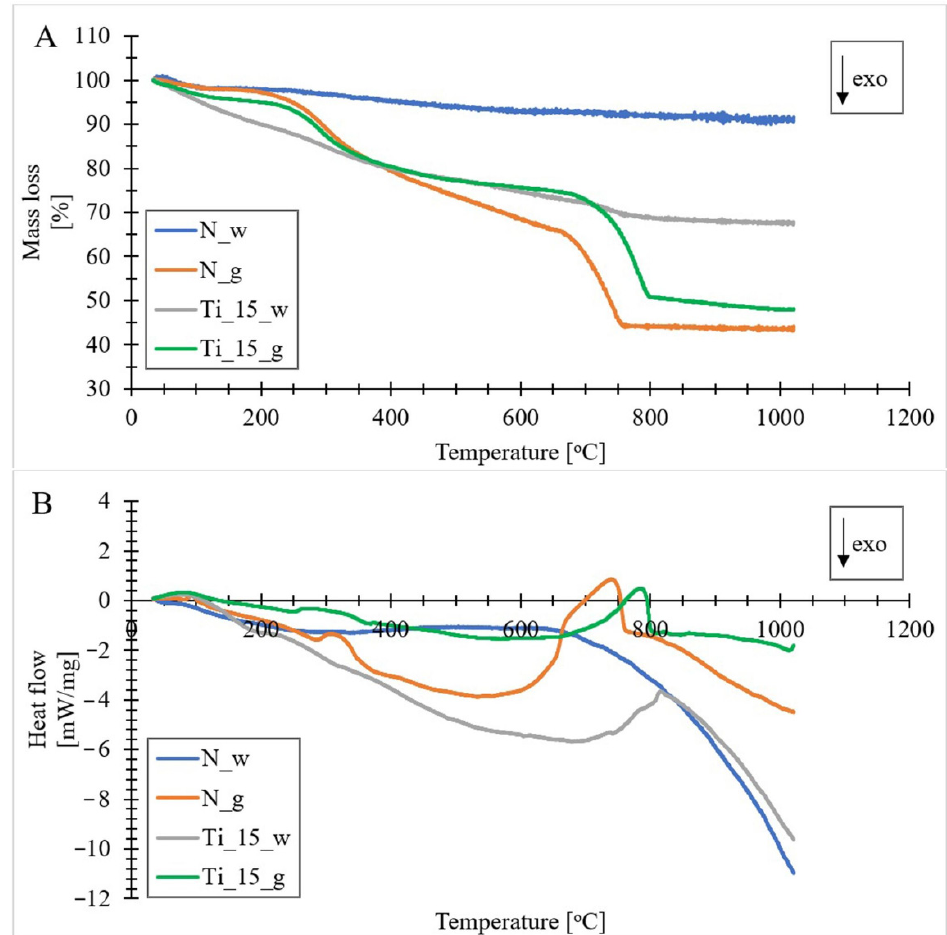
Figure 8. Graphs obtained from thermogravimetric analysis ( A ) and differential scanning calorimetry ( B ) of the obtained materials (N_g-undoped biomass; N_w-pure diatomaceous biosilica; Ti_15_g-the biomass doped with titanium ions with a concentration of 15 mg Ti/L; Ti_15_w-the biosilica doped with titanium ions with a concentration of 15 mg Ti/L).